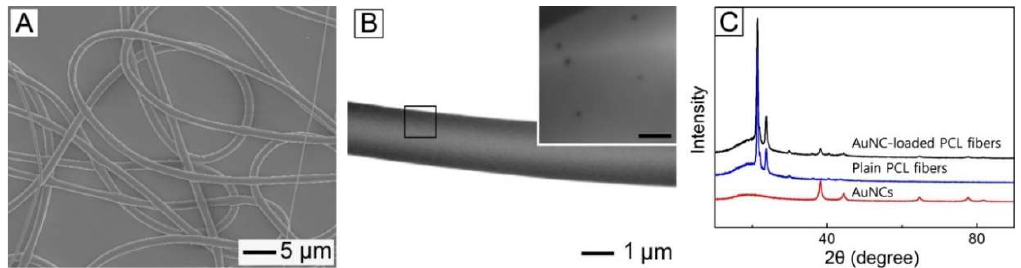
Figure 3. ( A ) SEM and ( B ) TEM images of PCL fibers loaded with AuNCs. The scale bar in the inset is 300 nm. ( C ) XRD patterns for AuNCs, plain PCL fibers, and AuNC-loaded PCL fibers. 300 nm. ( C ) XRD patterns for AuNCs, plain PCL fibers, and AuNC-loaded PCL